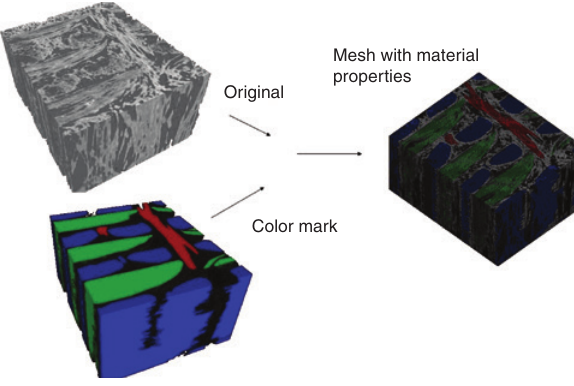
Figure 2: Relationship between the FEM model and the virtual 3D